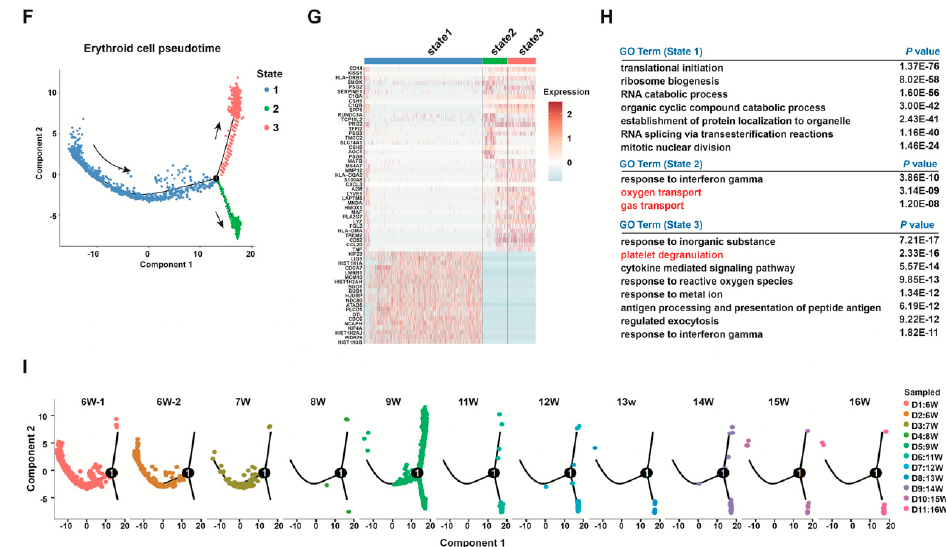
Figure 7. Immune cell and erythroid cell analysis. ( A ) UMAP plot and violin plots of HLA-A, HLA-B, CD9, FOLR2, and CCR4 log-normalized gene expression in Hobauer cells and macrophages. ( B , C ) Volcano plot of the DEGs between 6–7 weeks of gestation (6–7 W) and 14–16 weeks of gestation (14–16 W) for Hofbauer cells ( B ) and representative GO analysis terms of these DEGs in Hofbauer cells ( C ). ( D , E ) Volcano plot of the DEGs between 6–7 W and 14–16 W for macrophages ( D ) and GO analysis terms of these DEGs in macrophages ( E ). Genes with a log fold change greater than an absolute value of 2 were plotted. Genes with greater expression at 6–7 W are shown in red, and genes with greater expression at 14–16 W are shown in green. ( F ) In a pseudotime analysis of placental erythroid cells, cells on the tree were colored by state. ( G ) Heatmap of the top 20 DEGs of each erythroid state. ( H ) GO terms enriched among the DEGs of the three erythroid states. ( I ) Pseudotime analysis of placental erythroid cells, cells on the tree are colored by sample. DEGs, differentially expressed genes.